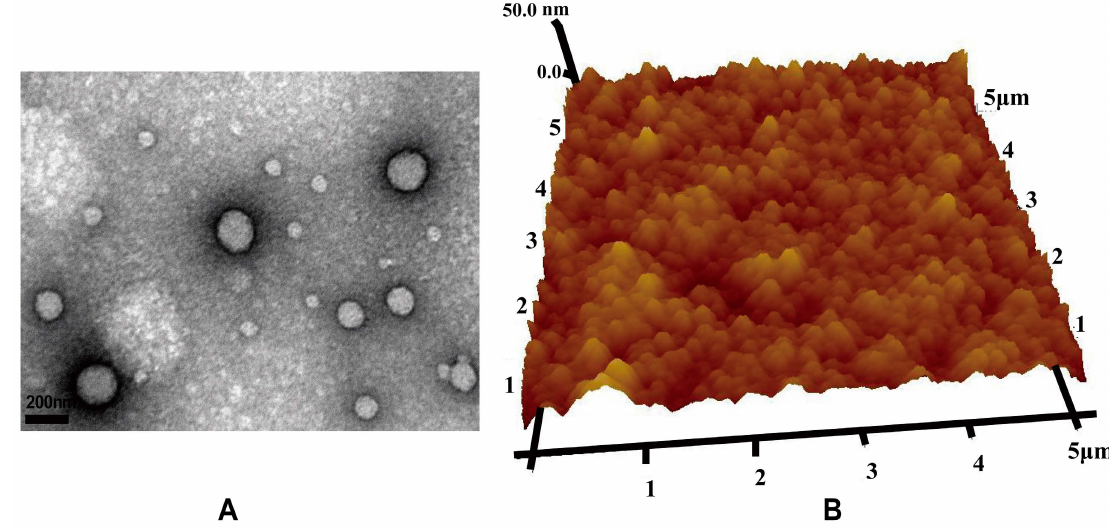
Figure 5. Morphology of VCM/TMC nanoparticles. ( A ) TEM image; and ( B ) AFM